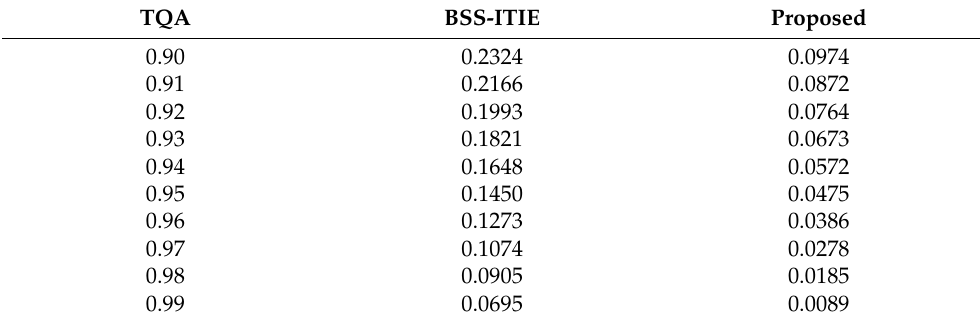
Table 7. Average vector quantization error comparison between the BSS-ITIE [28] method and the proposed method.